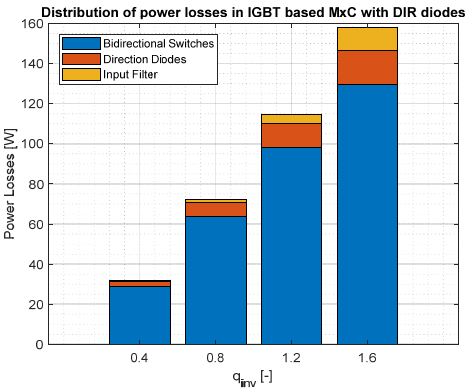
Figure 4. Distribution of power losses.